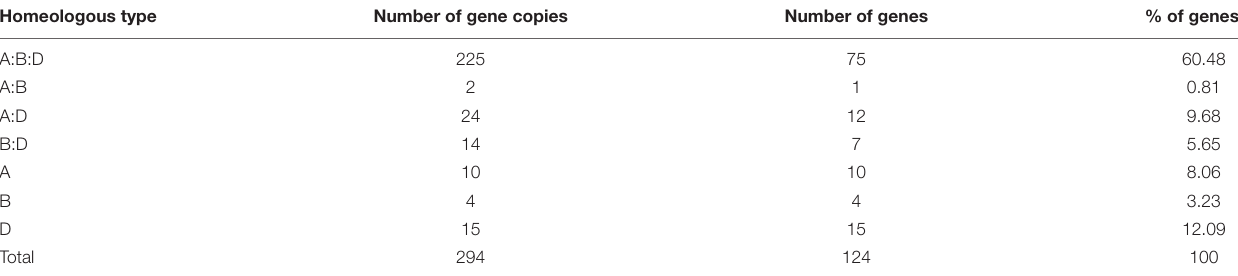
TABLE 1 | Types of homeologous WRKY genes in wheat.